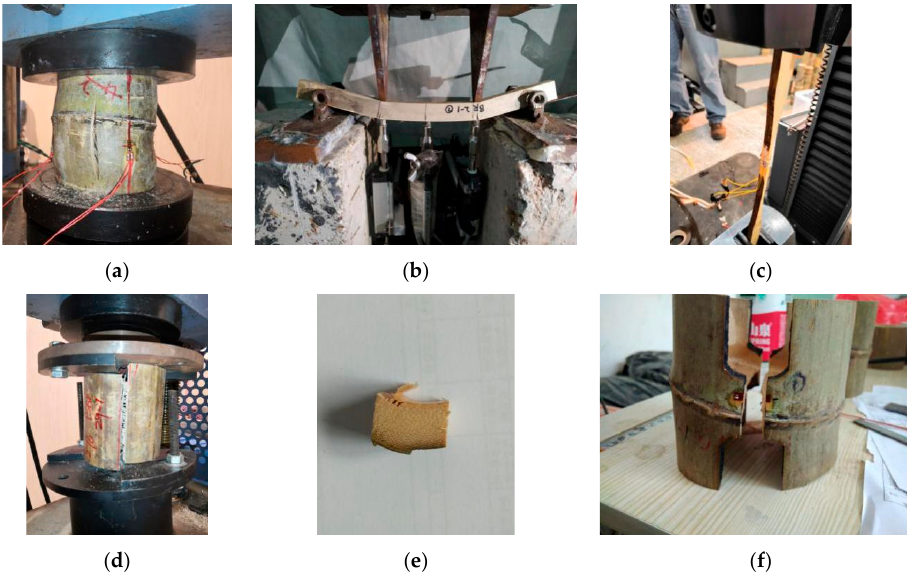
Figure 2. Typical failure modes of specimens: ( a ) UC; ( b ) B; ( c ) UT; ( d ) US; ( e ) CC; ( f ) CT.